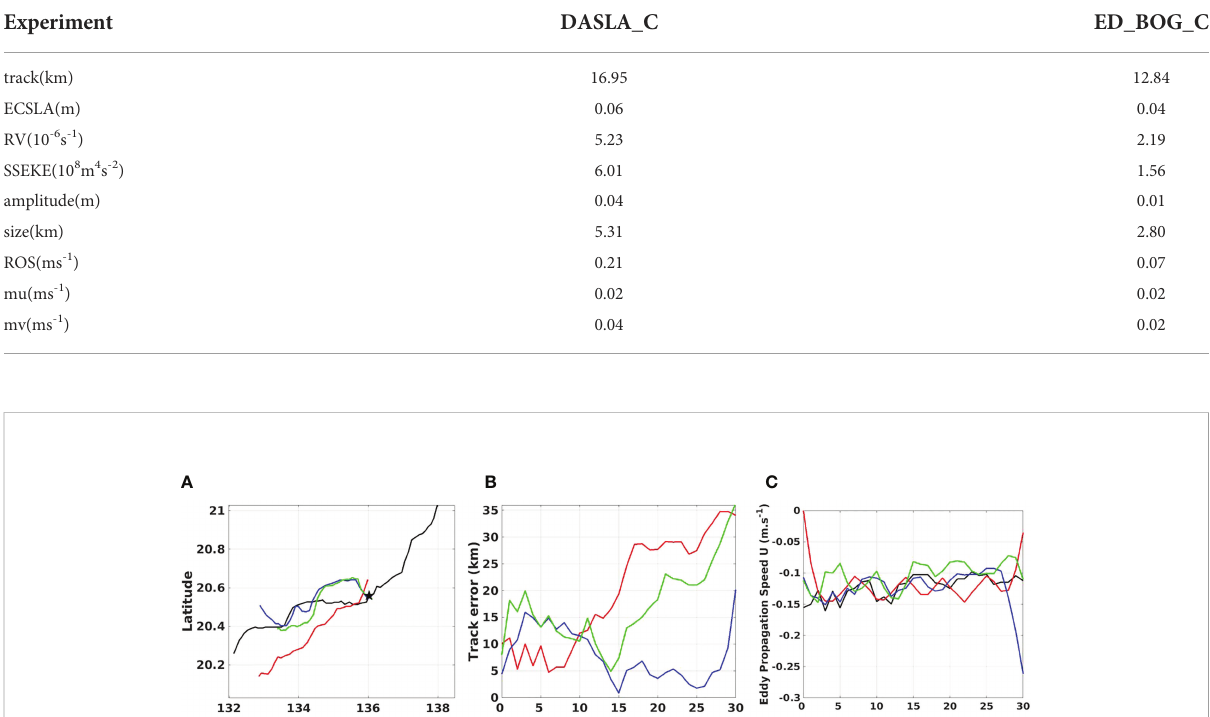
TABLE 4 The same as Table 3 except for the DASLA_C and ED_BOG_C.